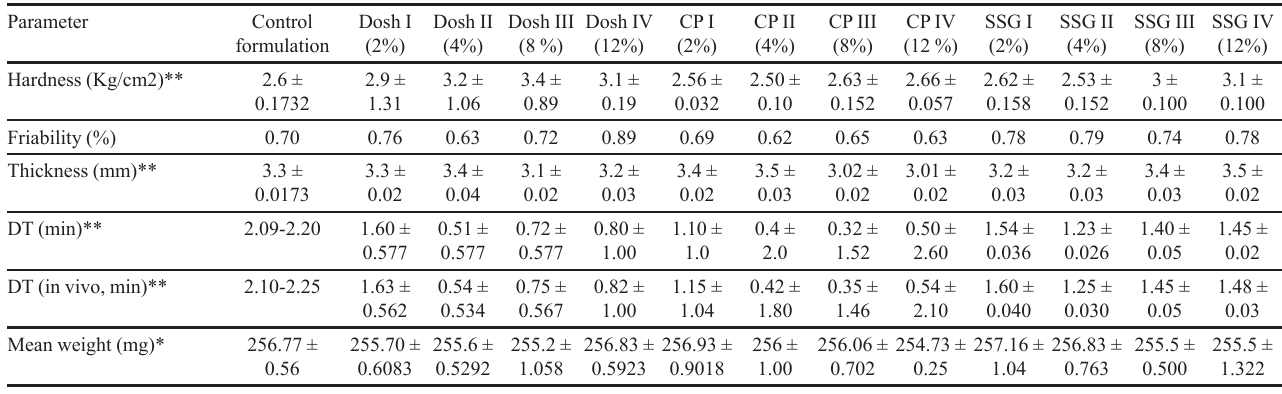
TABLE IV - Evaluation of the formulation